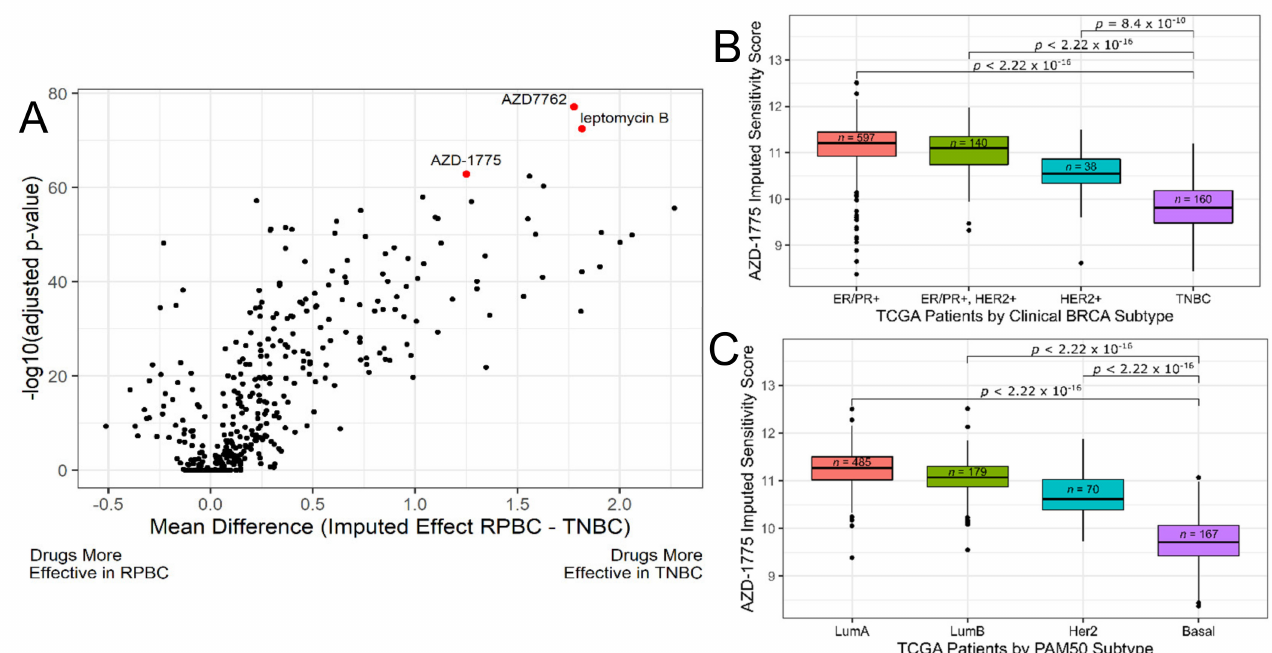
Figure 1. AZD-1775 is predicted to be most effective in TCGA triple-negative breast cancer (TNBC) patients. ( A ) Volcano plot of TNBC vs. receptor positive breast cancer (RPBC, i.e., non-TNBC) imputed sensitivity t-test results for all drugs in CTRP. 427 drug response models were applied to the TCGA breast cancer cohort resulting in an imputed sensitivity score for each patient. A t-test was then performed for every compound between the compound’s imputed response in TNBC and non-TNBC (RPBC) patients. The p -values were Bonferroni-adjusted to correct for multiple testing. Highlighted in red are the top 3 most significant results (AZD7762, leptomycin B, and AZD-1775). ( B , C ) AZD-1775 imputed sensitivity in TCGA breast cancer tumors by receptor status ( B ) and PAM50 subtyping ( C ). Boxplots summarize results of each tumor sample’s imputed sensitivity score to AZD-1775 in the TCGA breast cancer cohort by subtype. The n values indicate the number of patients in each group and p -values shown are adjusted for multiple testing. Lower values on the y-axis indicate increased